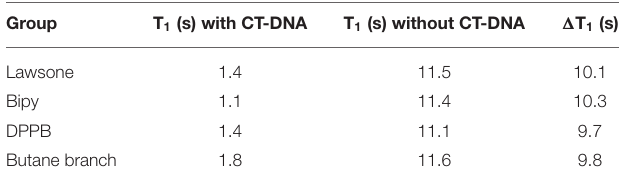
TABLE 1 | 1 H T 1 relaxation times determined for the Ru-complex CBLAU in solution (5mM) and in the presence of CT-DNA (50 µ M). Results collected at 298K (600